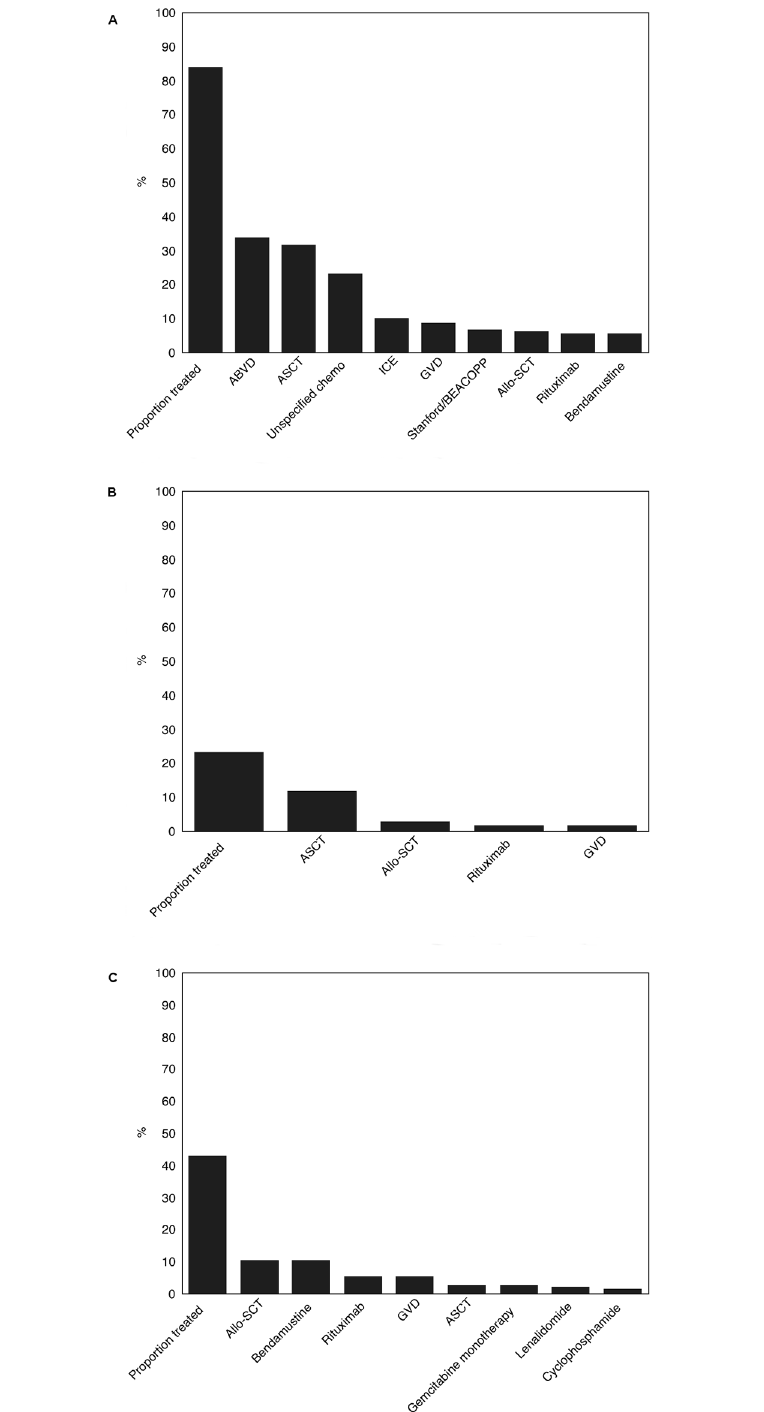
Fig 2. Frequency of therapies occurring a) in a line of therapy prior to BV; b) within the same line of therapy as BV; and c) in a line of therapy after the line of therapy including BV.